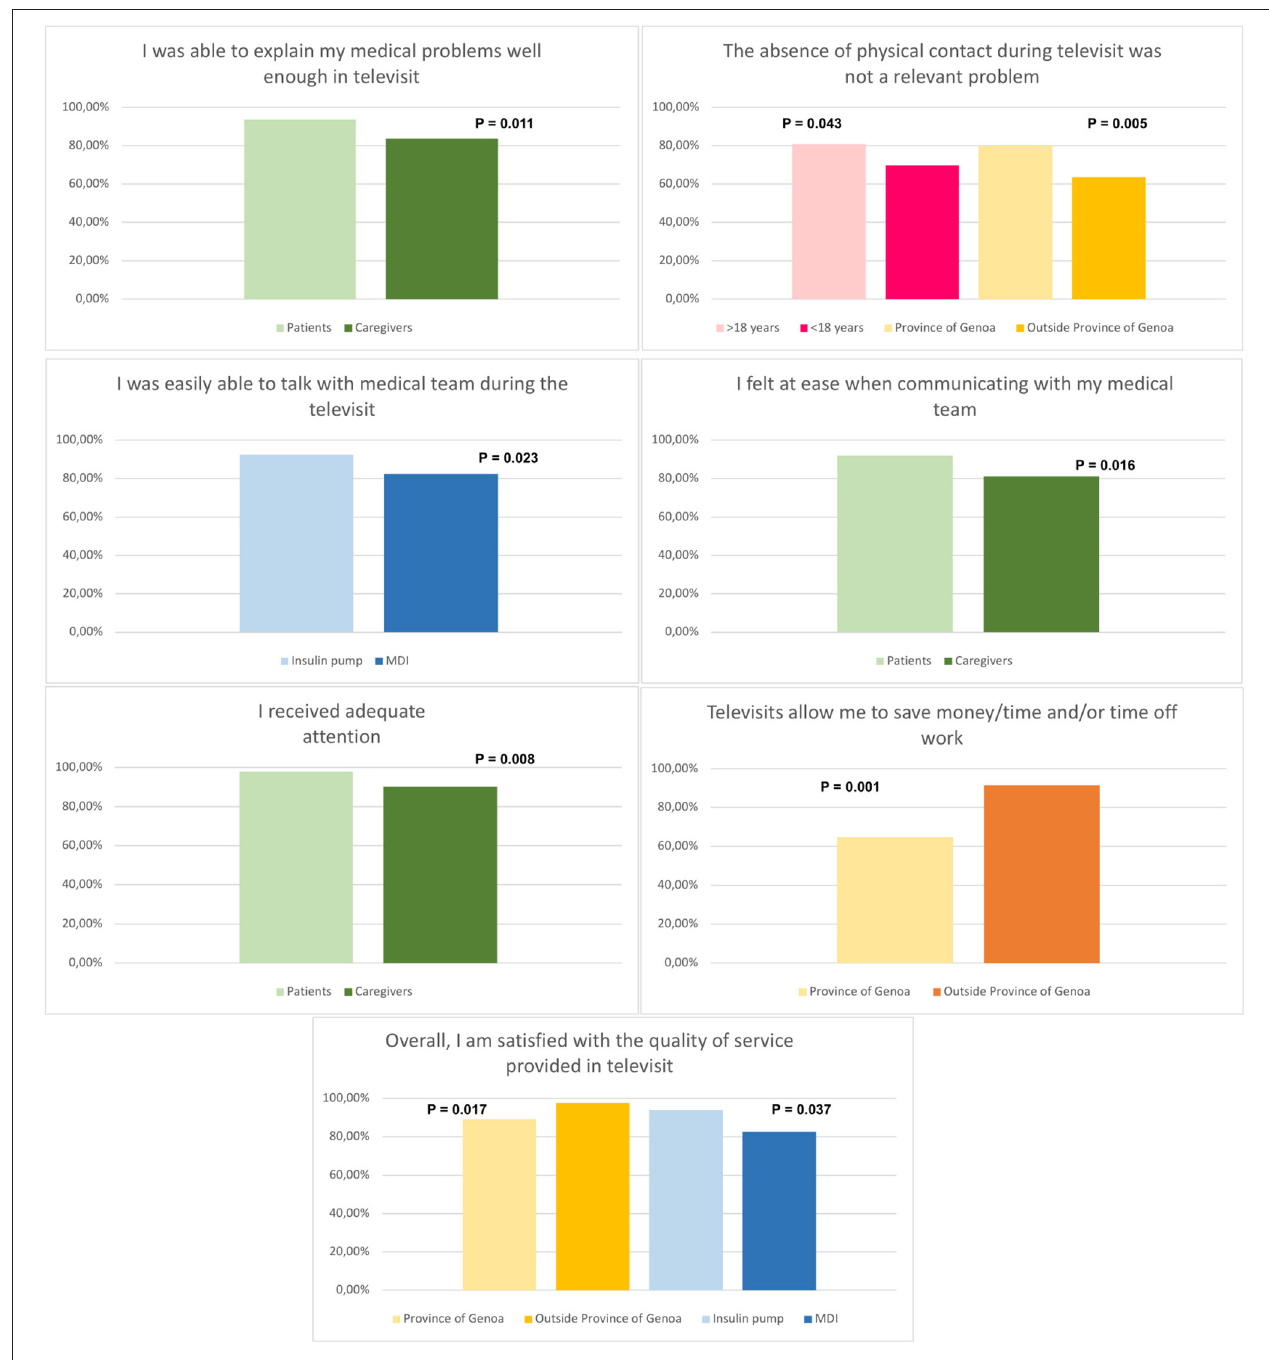
FIGURE 1 | Percentage of responders who assigned neutral (0–6) and high ( ≥ 7) scores for each